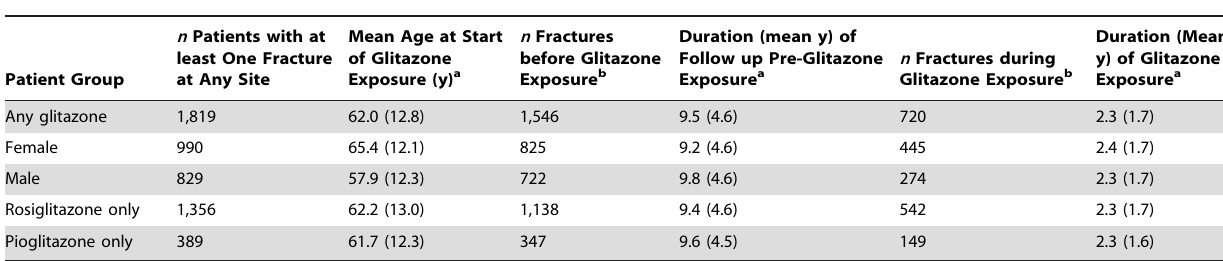
Table 1. Demographic details of study